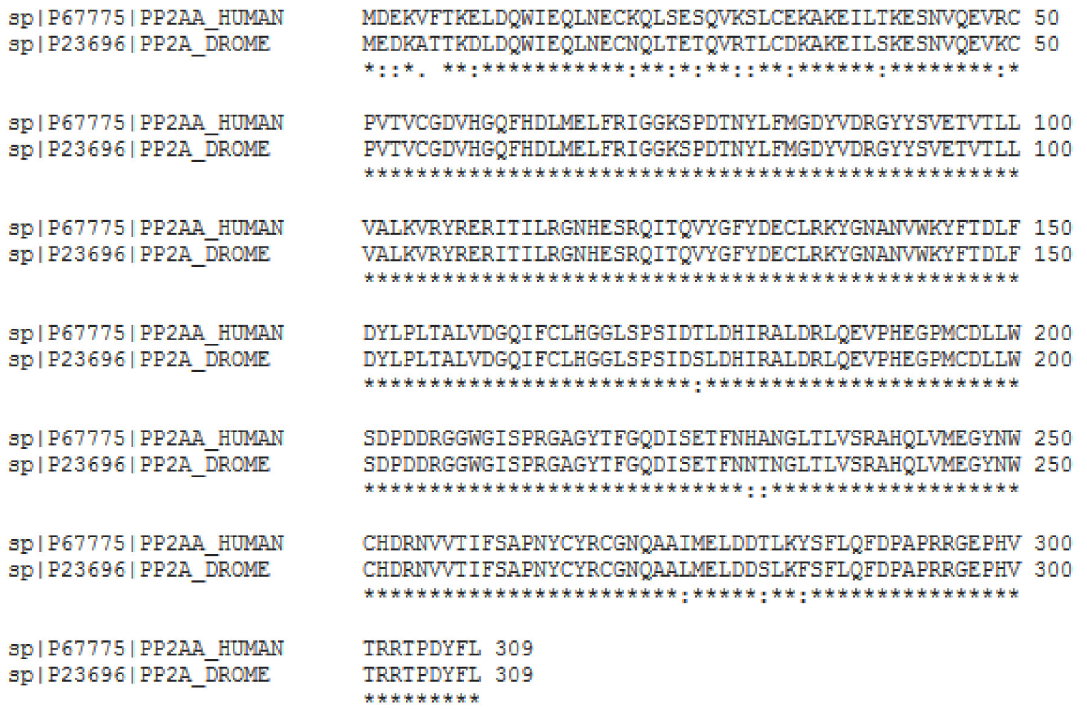
Figure 6. An example of Human/Drosophila conserved protein. PPP2CA/mts pair was found in Nautilus and squid as a potential candidate for lens evolution. These pairs were discarded from our analysis due to the high conservation of the Human and Drosophila proteins. Asterisk(*) indicate sequence identity, colon(:) indicates strongly similar properties and period(.) indicates weakly similar properties